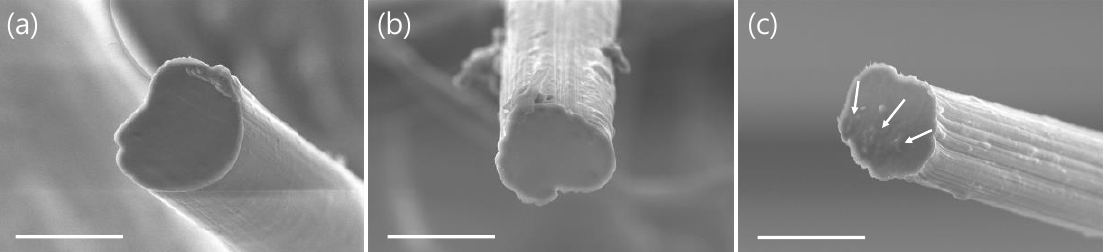
Figure 3. Scanning electron microscopy cross-section images of polyvinyl alcohol composite fibers with ( a ) 0.5, ( b ) 1.0, and ( c ) 3.0 wt% edge-selectively oxidized graphene; the scale bar is 50 um.